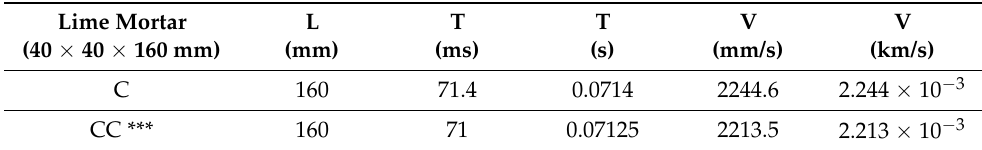
Table 7. Results for direct ultrasonic testing of lime mortar specimens treated with MYXOSTONE M3P (mean values).